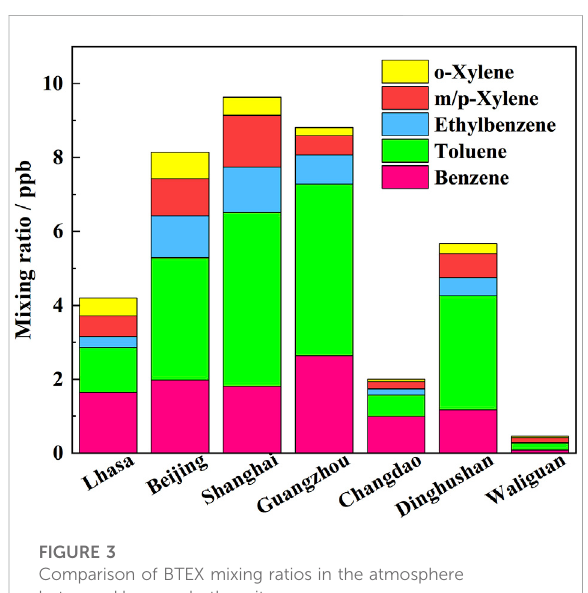
Comparison of BTEX mixing ratios in the atmosphere between Lhasa and other